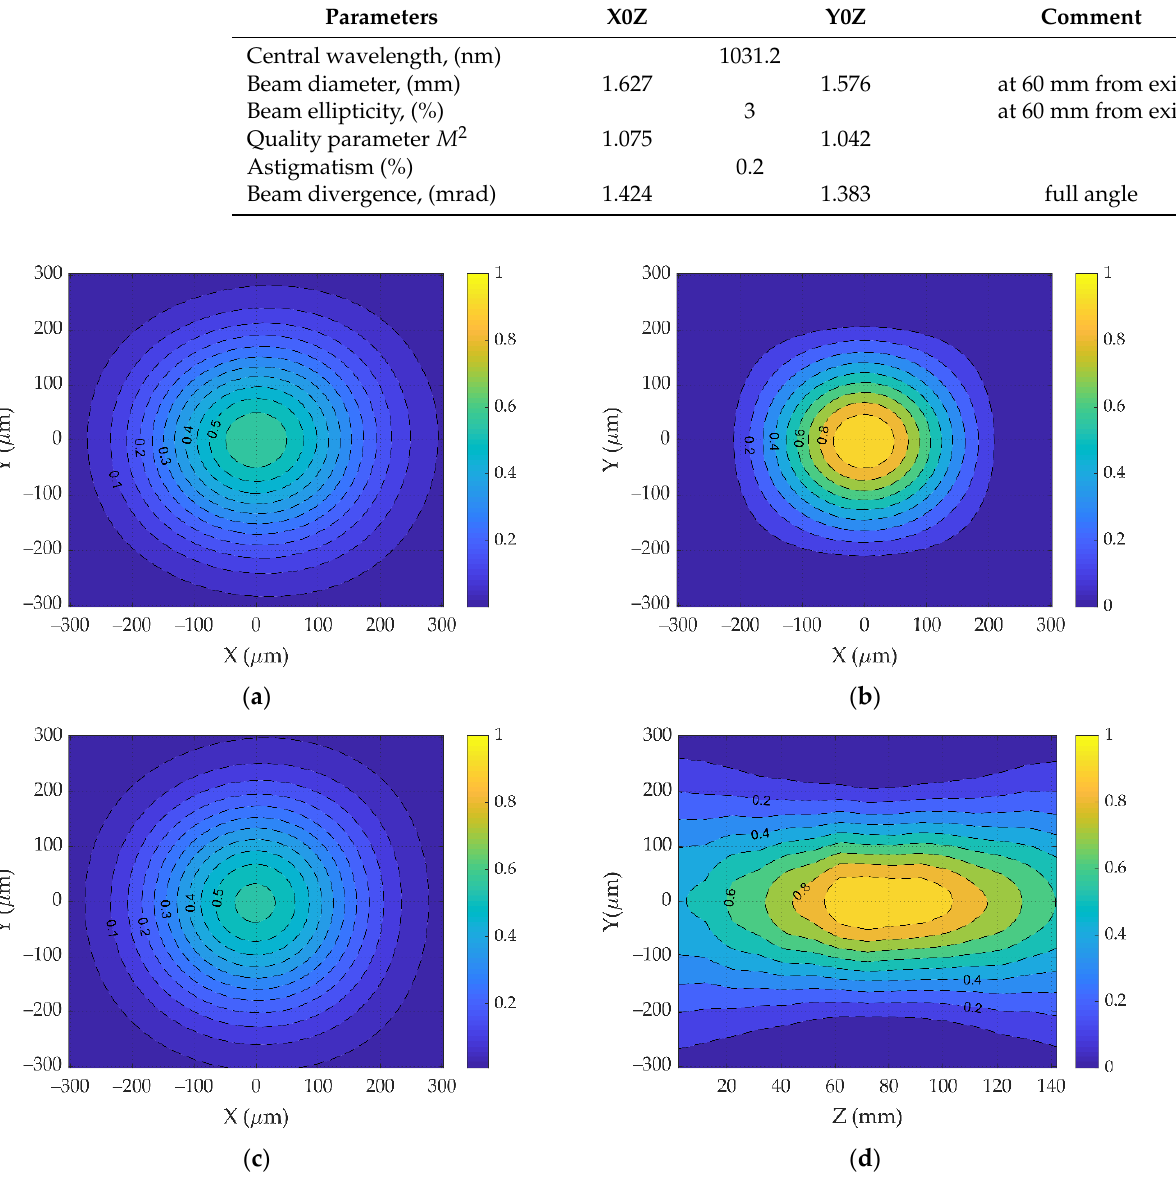
Figure 4. Cross-sections of the intensity distribution in planes with ( a ) Z = 22 mm; ( b ) Z = 82 mm; ( c ) Z = 140 mm; ( d ) Reconstructed longitudinal intensity